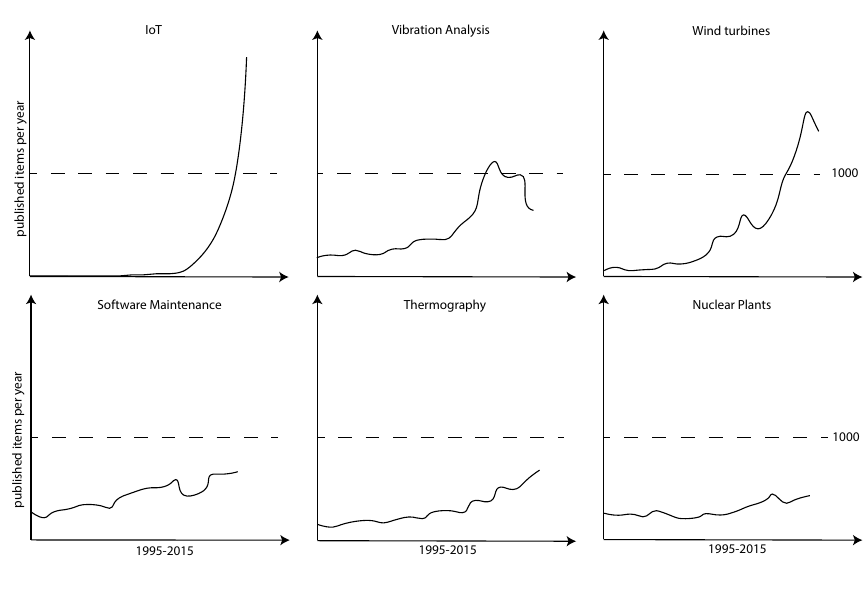
Figure 17. Published Items Per Year.